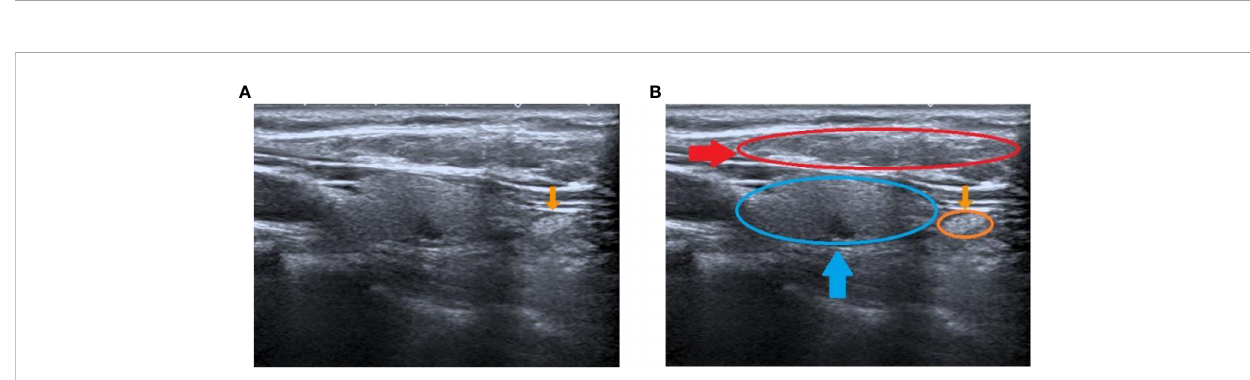
FIGURE 2 Preoperative ultrasound identi fi cation of the IPG. (A) yellow arrow shows the IPG; (B) yellow arrow and circle show the IPG, blue arrow and circle show the thyroid, red arrow and circle show the